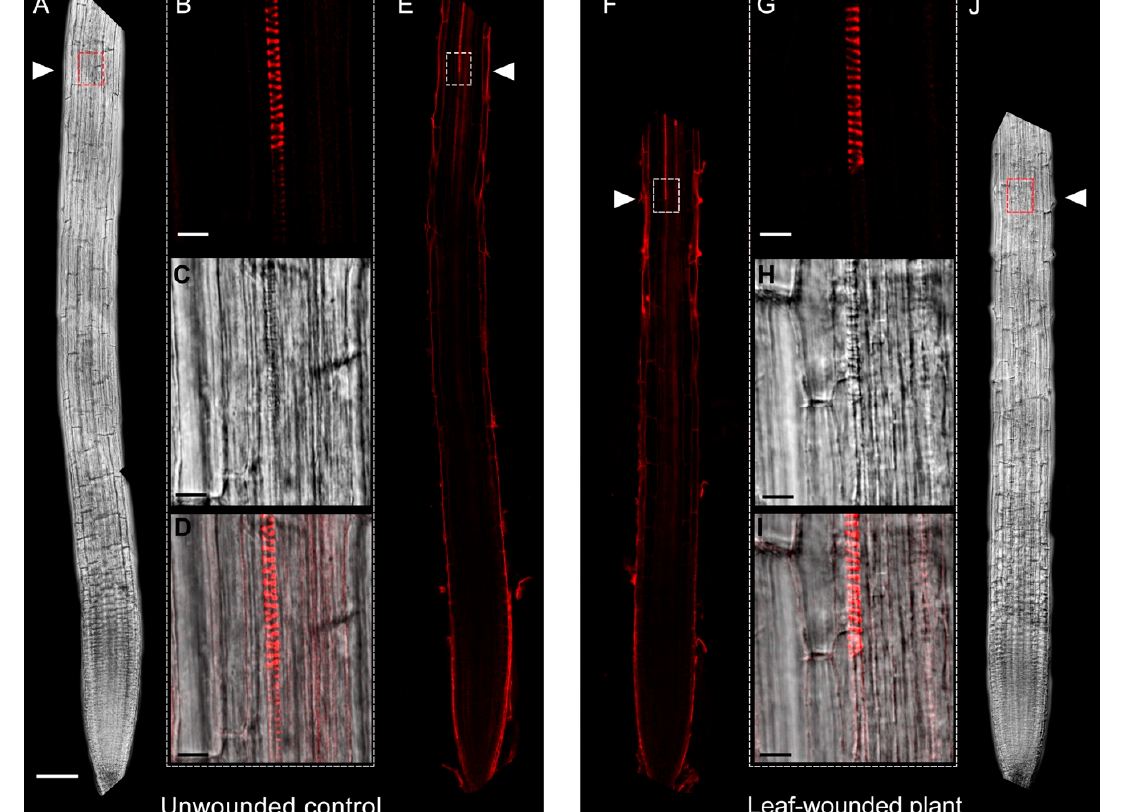
Figure 1. Analysis under LSCM after PI staining of root apexes and respective bright-field images from 10-day-old unwounded control ( A – E ) and leaf-wounded ( F – J ) seedlings. ( A – E ) bright-field of the root from unwounded control seedlings ( A ), PI staining ( B ) bright-field ( C ) and overlay image ( D ) of the magnified zone of the root from unwounded control seedlings, in which protoxylem position (defined by the position of the first protoxylem cell with fully developed secondary cell wall thickenings) is located, PI staining of the root shown in A ( E ); ( F – J ) PI staining of the root from leaf-wounded seedling injured at the age of 7 days by cutting the cotyledonary leaf, analysed 3 days after injury ( F ), PI staining ( G ) bright-field ( H ) and overlay image ( I ) of the magnified zone of the root from leaf-wounded seedlings, in which protoxylem position is located, bright-field of the root shown in F ( J ). The images presented are representative of experiments repeated at least five times with ten seedlings analysed each time. Shown images were obtained aligning serial overlapping micrographs of the same root by Photoshop Software (Adobe). Bars: 100 µm ( A , E , F , J ) and 10 µm ( B – D , G – I ).